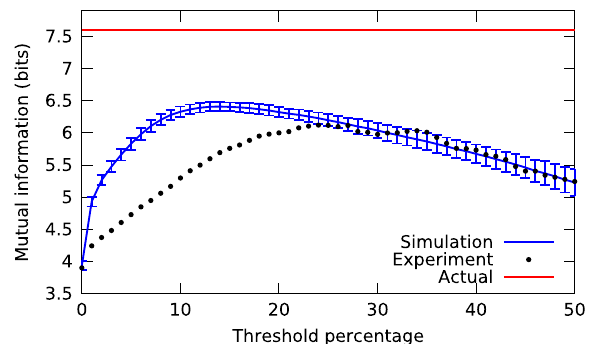
FIG. 5. Mutual information versus thresholding. The mutual information for reconstruction values above a thresholded per- centage of the maximum is given for 100 n ¼ 256 pixel simu- lations, with m ¼ 2500 measurements and (cid:3) ¼ 5000 photons per measurement. The solid red line gives the true mutual information for the simulated object. The black points give the n ¼ 256 far-field experimental data for comparison.